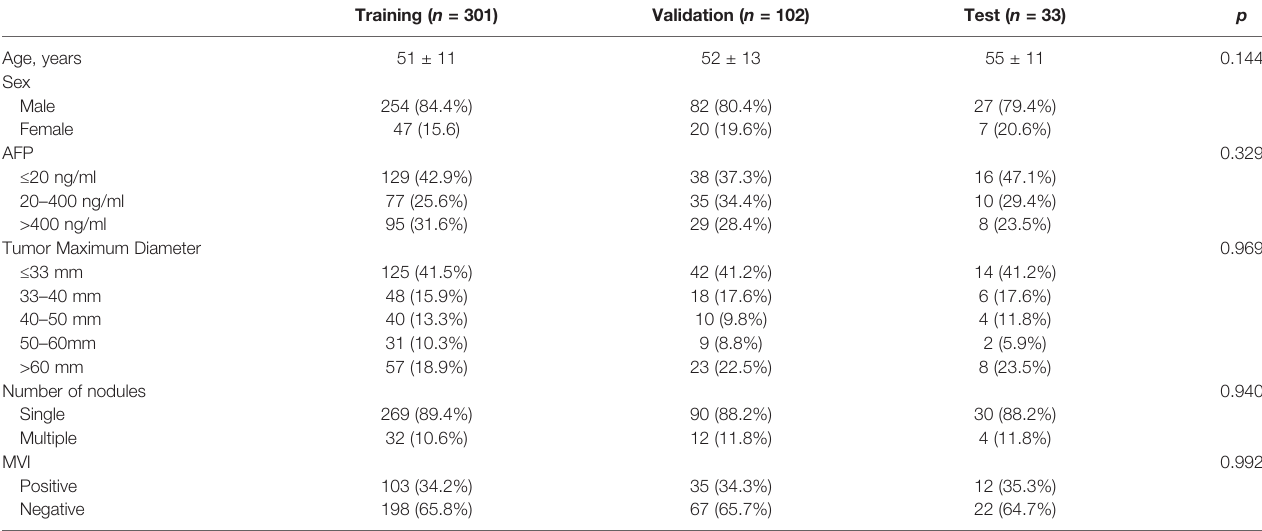
TABLE 1 | The clinical characteristics of training, validation, and test